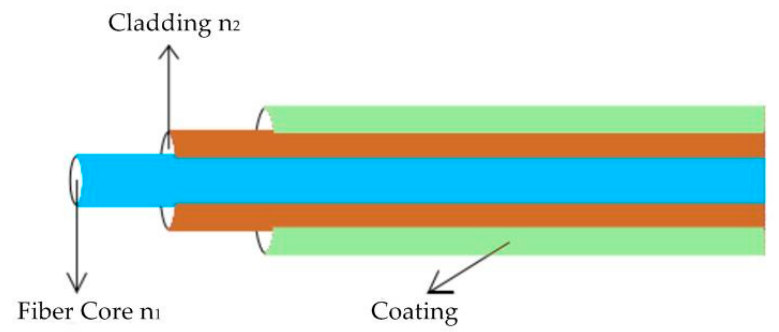
Figure 5. Schematic diagram of fiber optic.